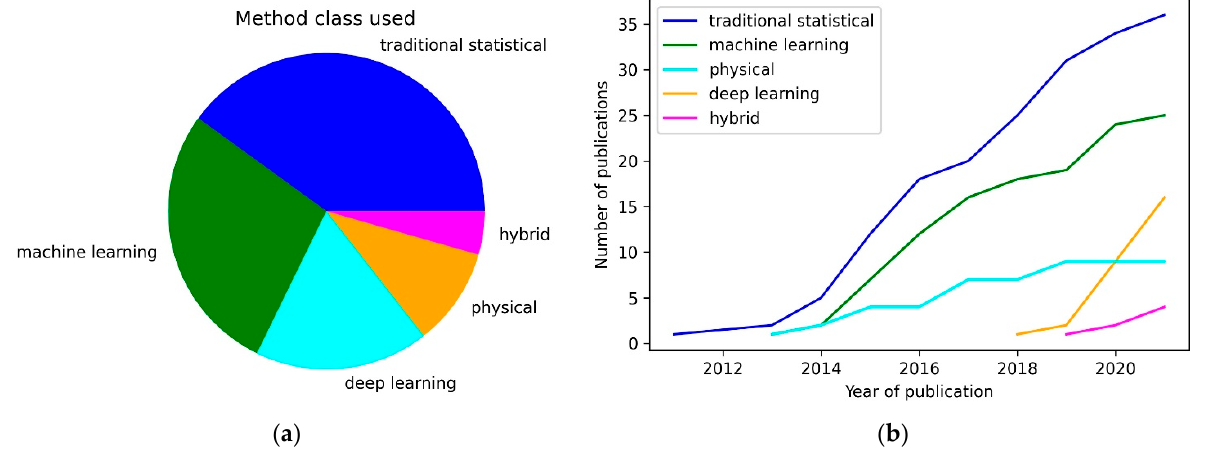
Figure 2. ( a ) Frequency of use of the forecasting methods applied in the reviewed studies; ( b ) corresponding cumulative number of publications through time.